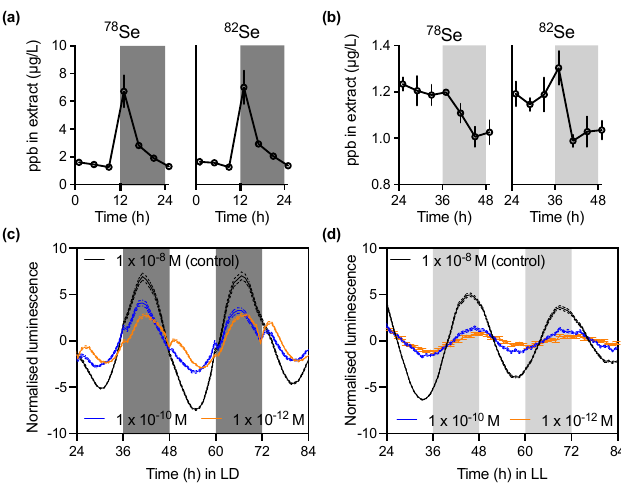
Figure 5. Interaction of selenium with the environmental and circadian cycles: ( a , b ) Cellular content of selenium, analysed by inductively coupled plasma mass spectrometry. The two detectable stable isotopes of selenium are 78 Se (left) and 82 Se (right), and these were measured under LD ( a ) or LL ( b ) conditions. Mean ± SEM; n = 3. ( c , d ) Luminescent imaging of the CCA1-LUC circadian clock marker under normal physiological concentrations of extracellular selenium (control) versus depleted levels 2 or 4 orders of magnitude lower. Cells were imaged over multiple cycles of 12 h/12 h light/dark (LD, ( c )) or constant light (LL, ( d )). Mean ± SEM; n = 32.